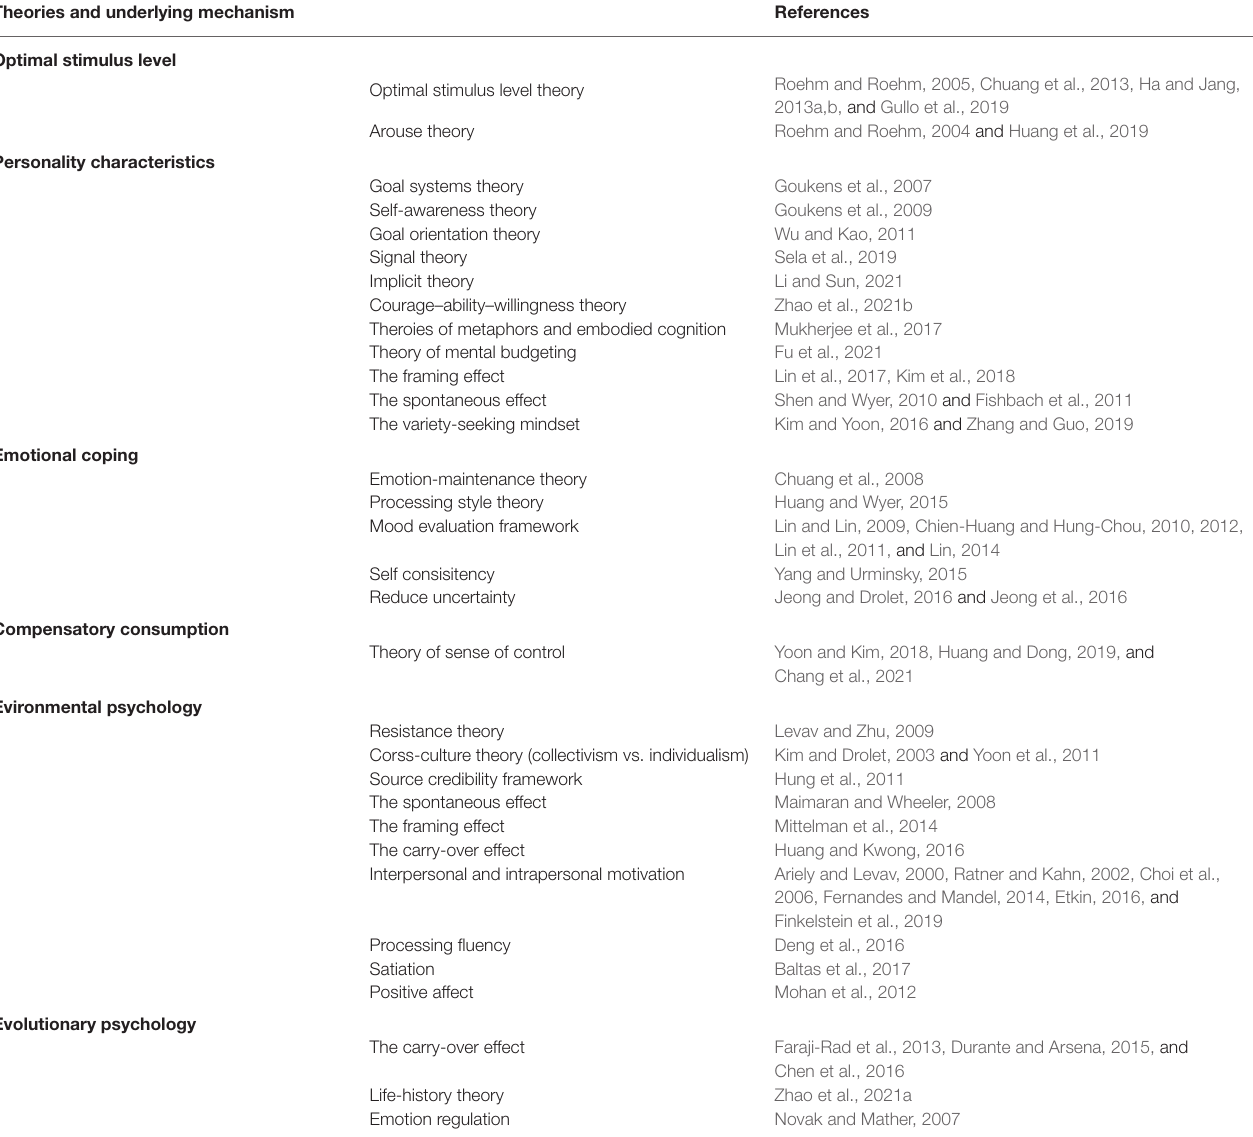
TABLE 2 | Theories and underlying mechanism used in variery-seeking behavior in consumption. Theories and underlying